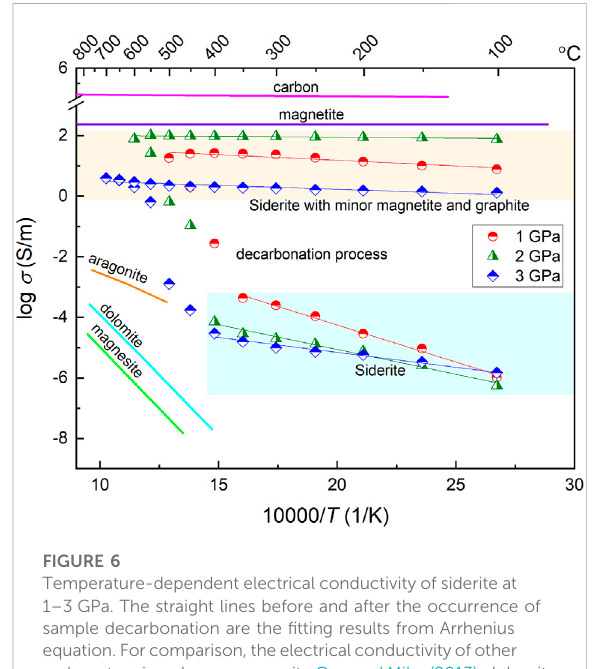
FIGURE 6 Temperature-dependent electrical conductivity of siderite at 1 – 3 GPa. The straight lines before and after the occurrence of sample decarbonation are the fi tting results from Arrhenius equation.Forcomparison,theelectricalconductivityofother carbonateminerals, e.g., aragonite Ono and Mibe(2013), dolomite Ono and Mibe (2015), and magnesite Mibe and Ono (2011), as well as the high conductive phases, e.g., magnetite Dai et al. (2019) and graphite Yoshino and Noritake (2011) are shown as solid lines with different